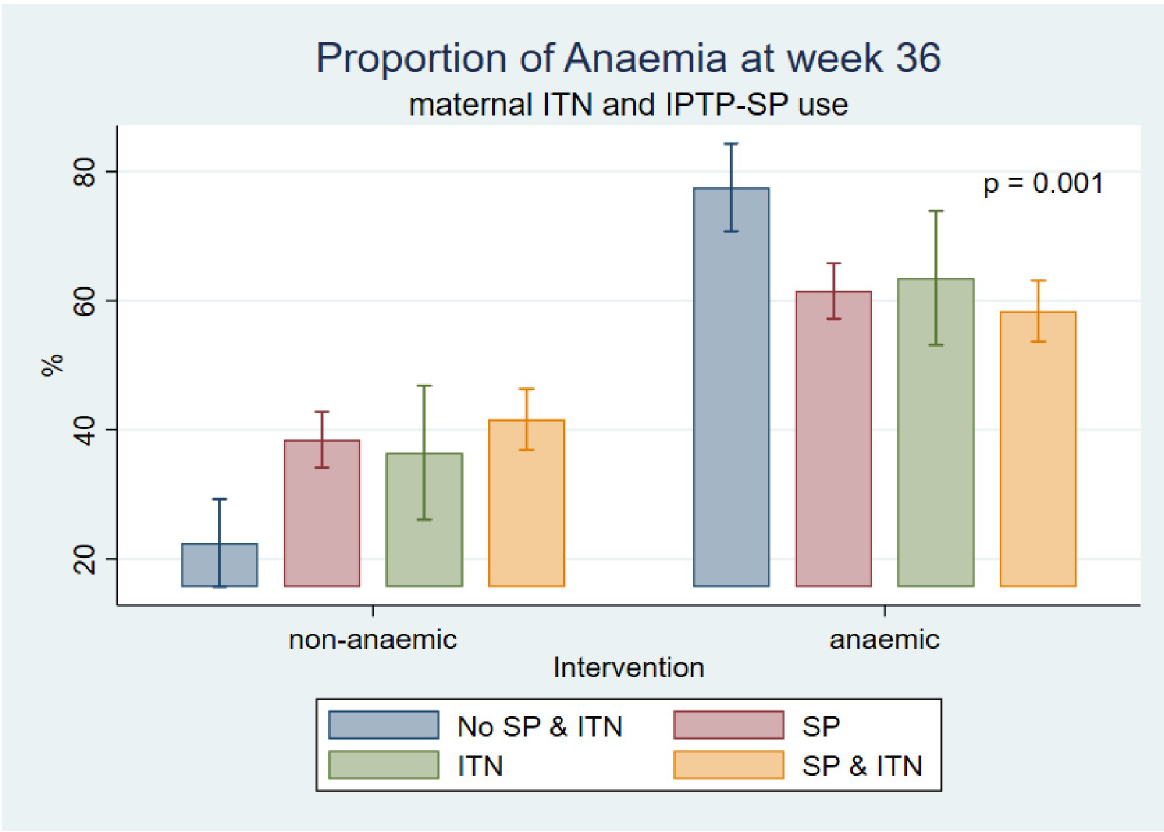
Fig 2. Maternal ITN/IPTp-SP use and anaemia.